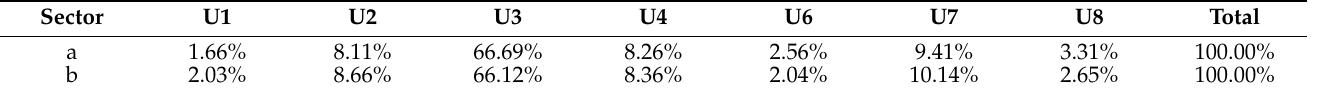
Table 2. The percentages of energy consumption net flows of construction